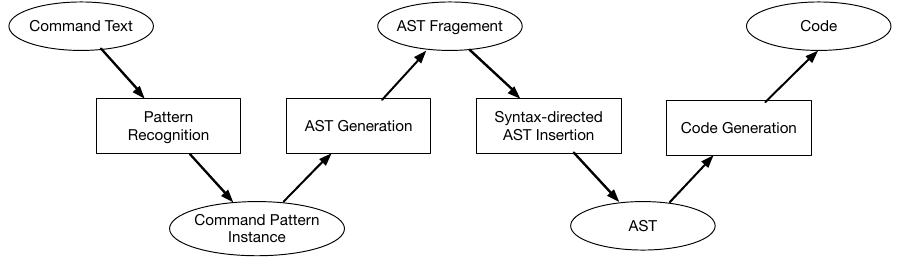
Figure 2. Architecture